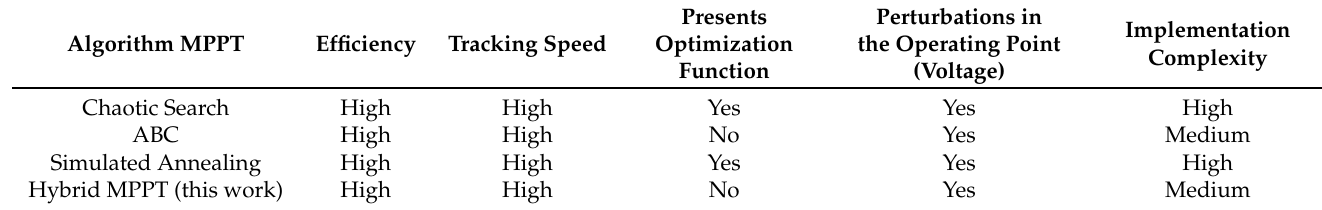
Table 2. MPPT algorithm